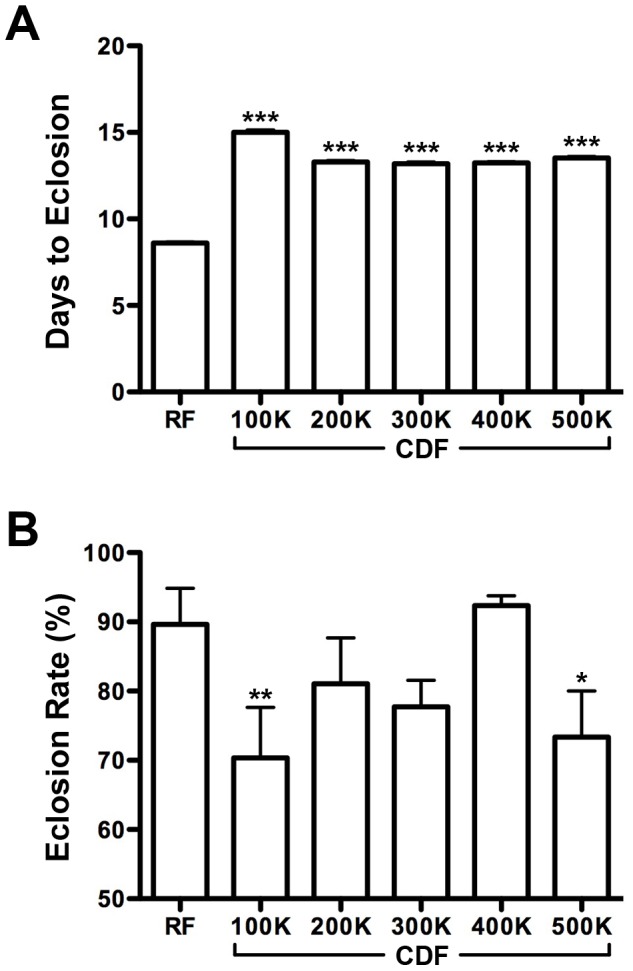
The effect of CDF on larval development and survival.(A) Days required for first instar larvae to eclose on chemically defined food. Larvae grown on CDFs show statistically significant developmental delay (Mann Whitney test; n ≥65, p<0.0001 for all; see Table S4A for details). (B) Eclosion rates for first instar larvae cultured on chemically defined food. Larvae on CDF200K–400K show no statistical difference in survival compared to RF (one-tailed Fisher’s exact test; n ≥65, p≥0.0544 for all; see Table S4B for details), but lower survival is observed on CDF100K and CDF500K (p = 0.0025 and 0.0202 respectively).